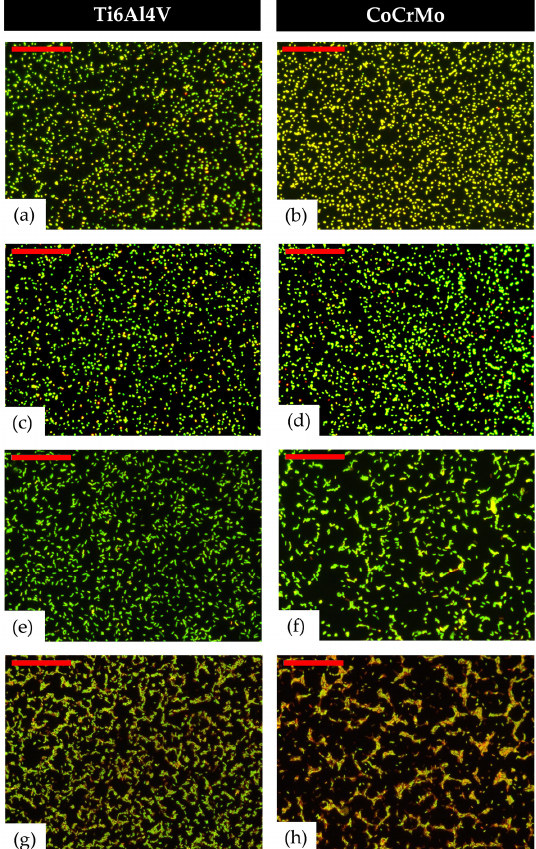
Figure 3. Images of S. aureus ( a , b ), S. epidermidis ( c , d ), E. coli ( e , f ), and P. aeruginosa ( g , h ) adhered on Ti6Al4V alloy ( a , c , e , g ) and CoCrMo alloy ( b , d , f , h ). DM 2000 Fluorescence microscope. The red bar represents 50 μ m.